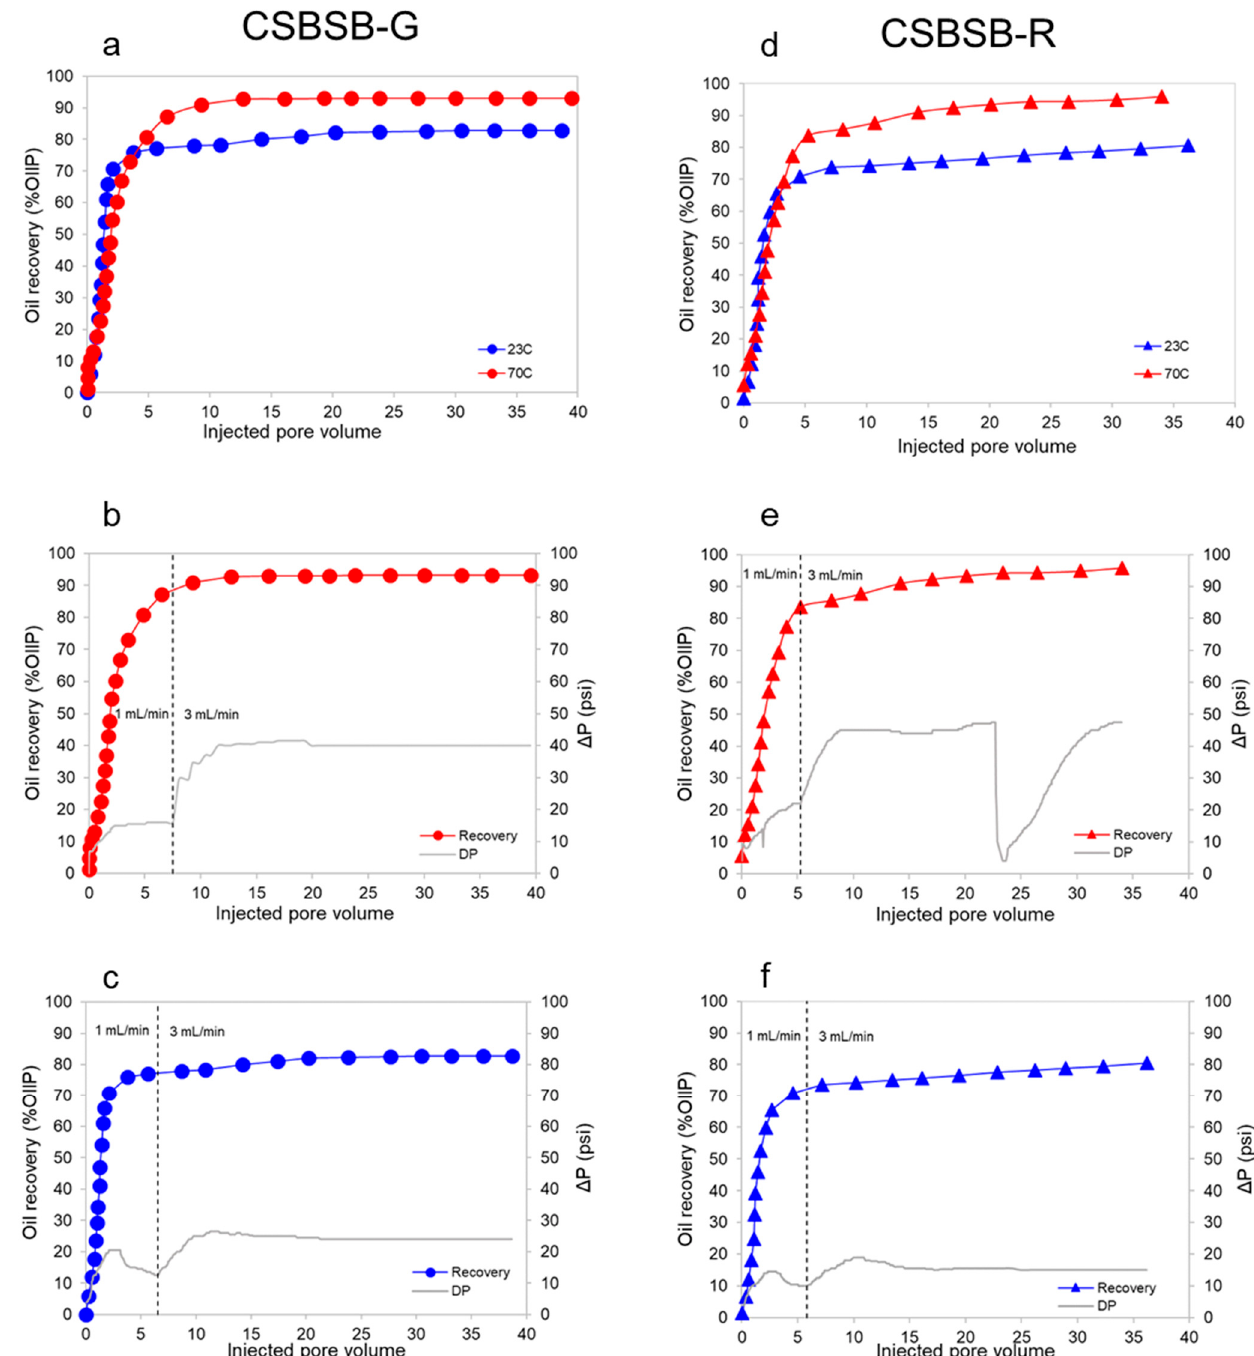
Figure 3. Oil recovery during secondary injection of CSBSB-G ( a – c ) and CSBSB-R ( d – f ). Red circles ( a , b ) correspond to biosurfactant flooding carried out at 70 °C on rock sample C14 with initial water saturation of S wi = 0.38, while blue circles ( a , c ) correspond to the experiments at 23 °C on rock sample C13 with S wi = 0.43. Red triangles ( d , e ) correspond to biosurfactant flooding carried out at 70 °C on sample C18 at S wi = 0.45, while blue triangles ( d , f ) represent the results obtained with C16 at 23 °C and with S wi = 0.42. Grey curves show the measured pressure difference across the samples and vertical dashed lines indicate a transition from the injection rate of 1 mL/min to 3 mL/min.